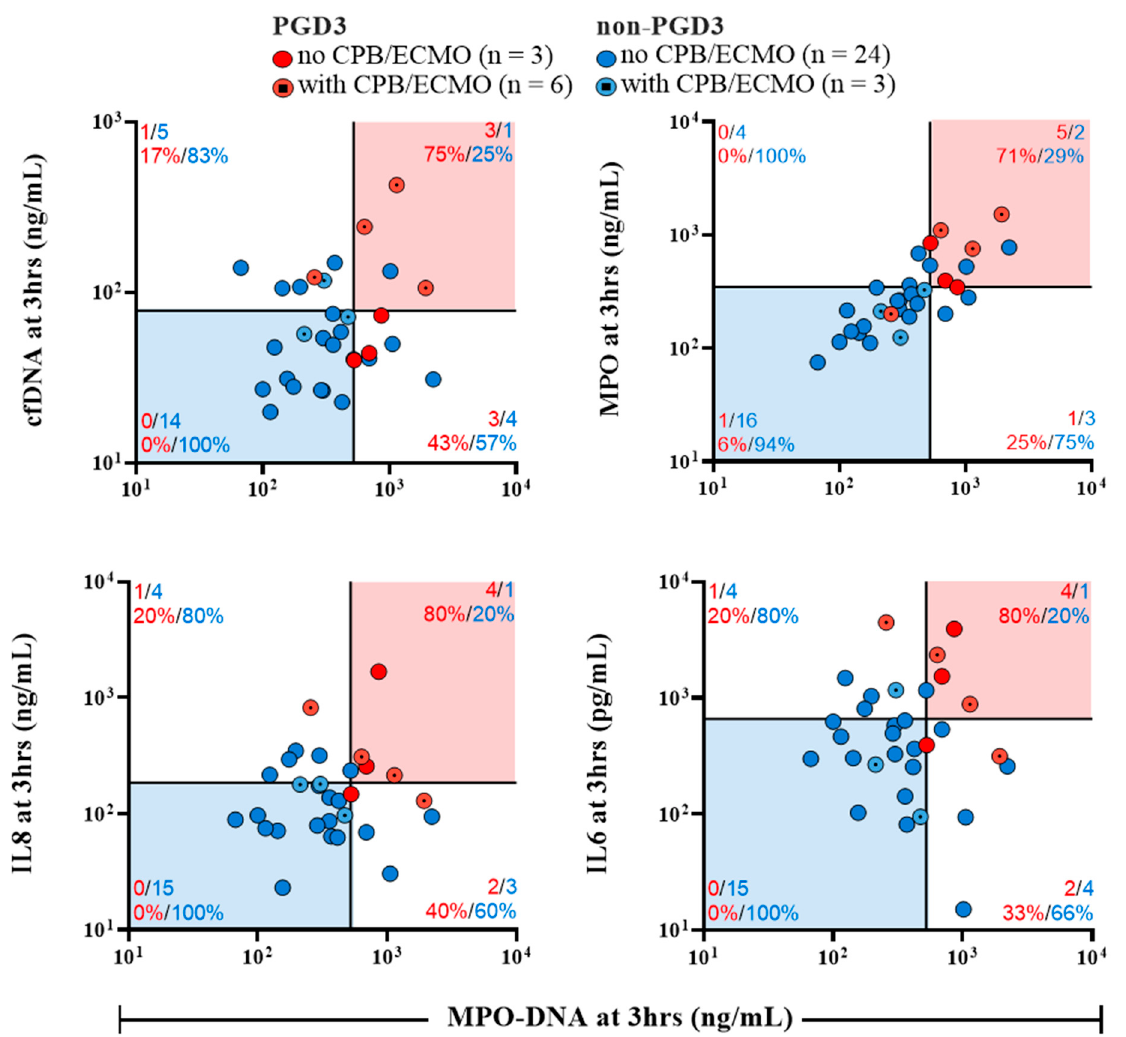
Figure 5. Prediction of PGD3 onset based on early postoperative (3 h) values of NETosis biomarkers and inflammatory cytokines inducing NETosis. Cut-off lines represent the 66th percentile value for each biomarker and limit four quadrants. The number of recipients belonging in each quadrant is displayed with colored numbers. For every binary combination of biomarkers, recipients located in the red zones have the highest risk of developing PGD3 whereas recipients in the blue zones have the lowest risk of developing PGD3 at 12 h. Both X and Y axis have logarithmic scales.